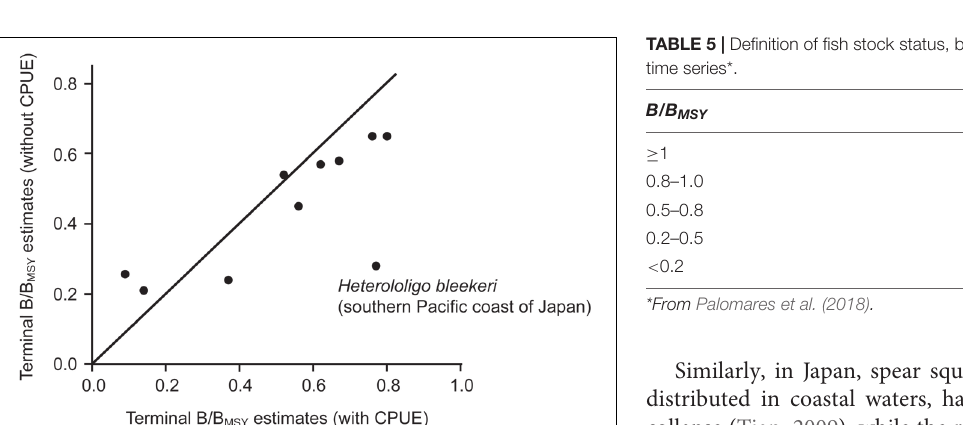
FIGURE 3 | Comparison of relative biomass trends estimated using the CMSY method (without CPUE, left) and BSM (with CPUE, right) for 10 stocks, with the gray areas representing the 95% confidence intervals. Note the match between the pairs of panels, from (A) vs. (B) to (S) vs. (T) .